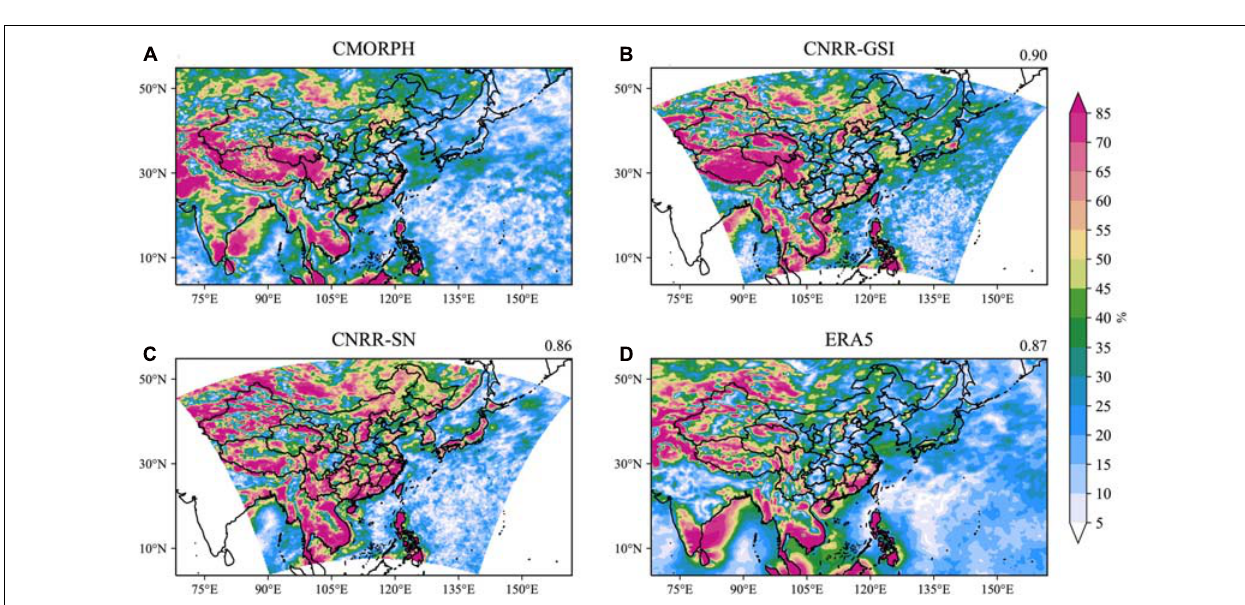
FIGURE 9 | Distribution of the normalized diurnal harmonic amplitude of precipitation amount (PA) from CMORPH (A) , CNRR-GSI (B) , CNRR-SN (C) and ERA5 (D) . The amplitude is normalized by dividing daily average precipitation. Unit: %.